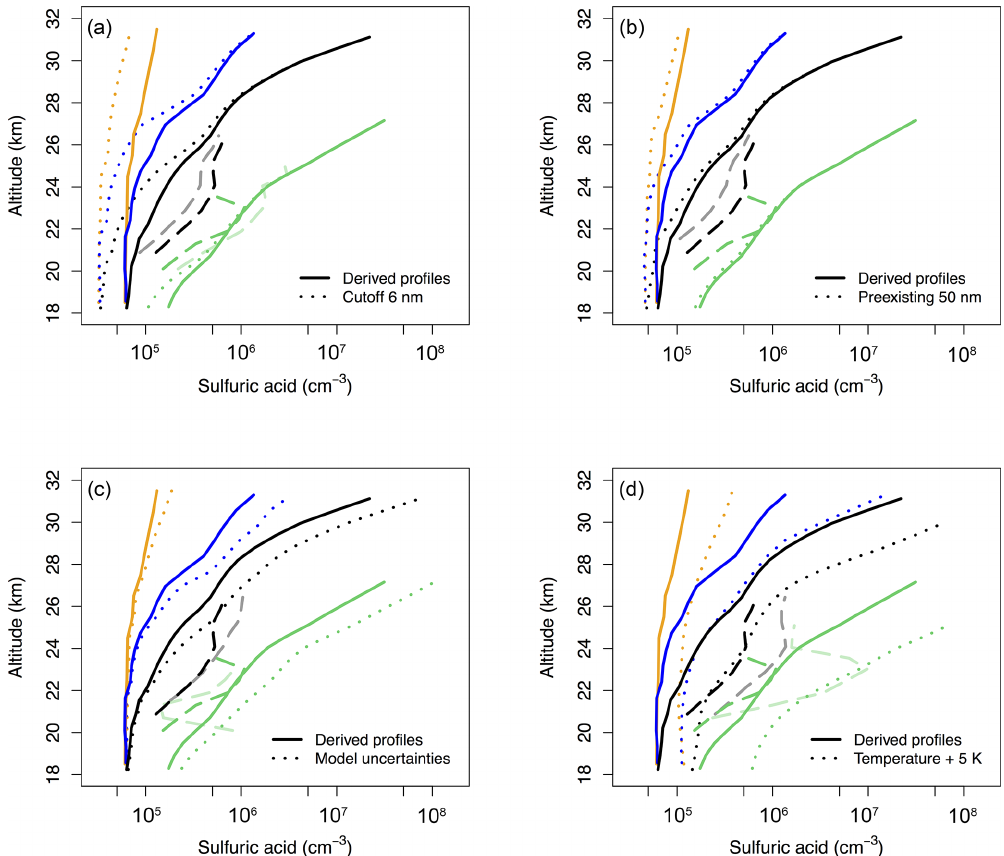
Figure 6. Sensitivity studies varying (a) CN counter cutoff size, (b) preexisting particle size, (c) model thermochemical and dynamic param- eters, and (d) temperature to estimate the uncertainties of the derived sulfuric acid profiles. As in Fig. 5, the solid and dark dashed lines show the nucleation threshold and CN layer formation profiles as presented in Fig. 4. The dotted and light dashed lines show the changed profiles according to the sensitivity